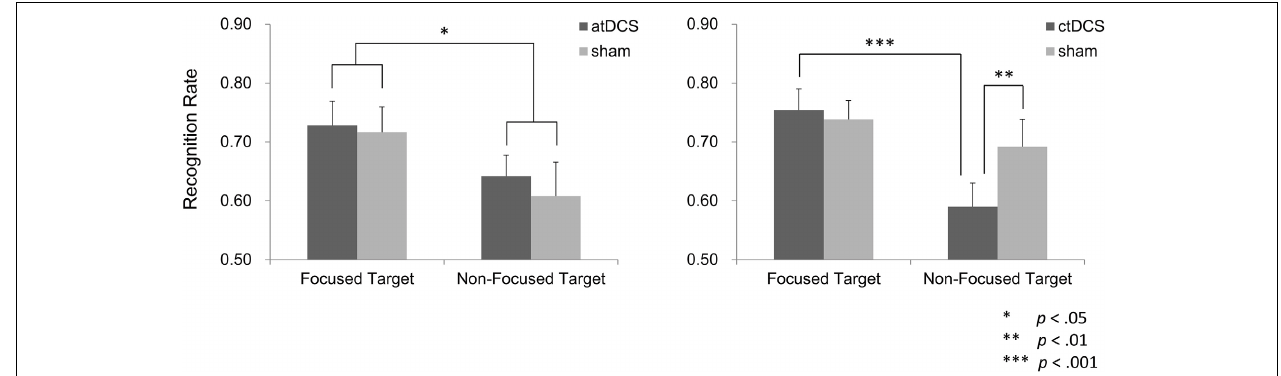
FIGURE 5 | Recognition performance of the target words. In the atDCS group, recognition performance was higher in the target words in the focus condition (focused targets) than in the non-focus condition (non-focused targets), although brain stimulation did not modulate the